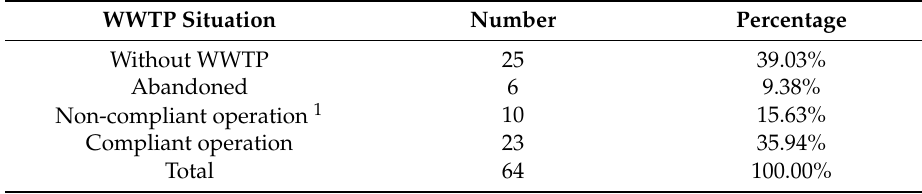
Table 1. Wastewater treatment plant (WWTP) situation in December 2017 for municipalities that generate a load of 2000 p.e. or